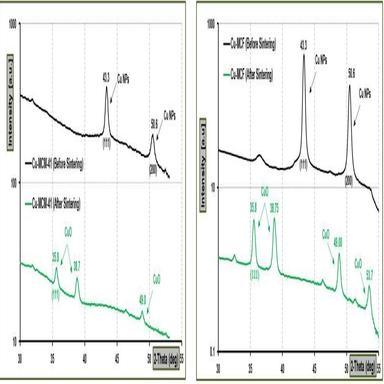
XRD patterns of the samples Cu-MCM-41 (left) and Cu-MCF (right) before and after sintering.